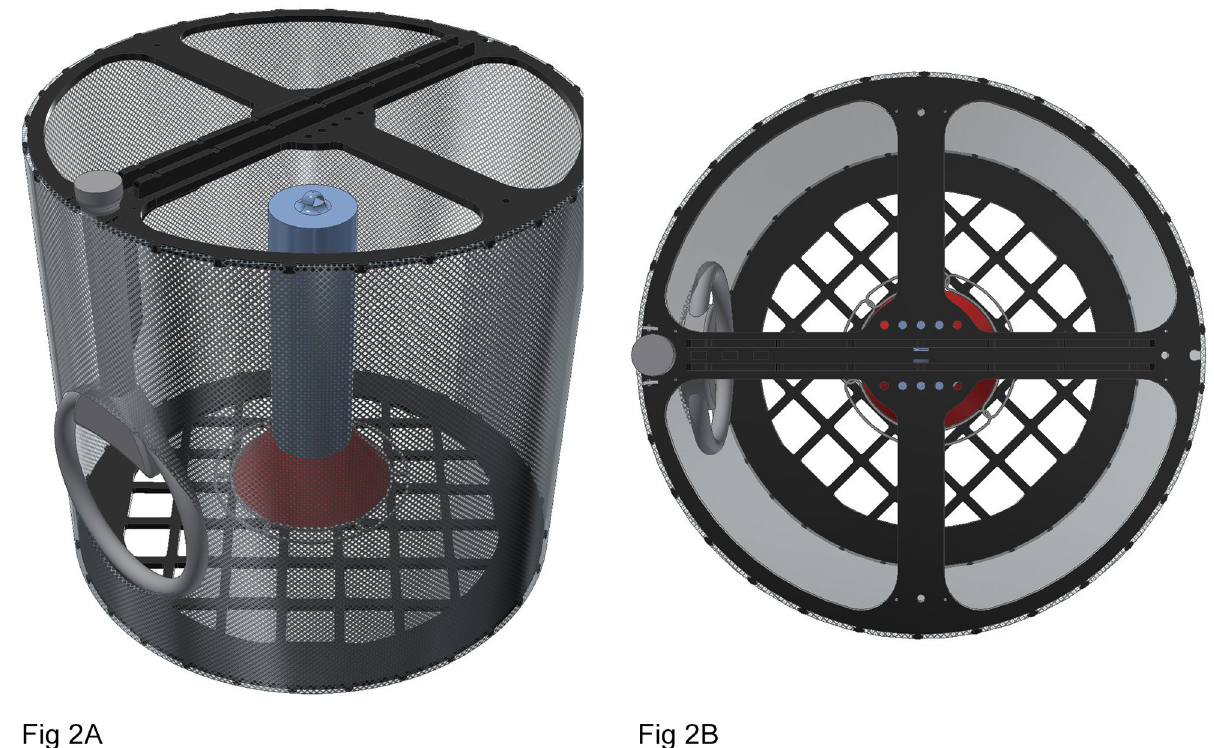
Fig 2. Computer-aided design drawings of (A) side and (B) top views of the single antenna feeding station using radiofrequency identification technology. The antenna was secured to the side of the feeder system using commercial cable ties that secured the antenna to the supporting perpendicular structure that originated from the top of the unit that extended down (A). The crossbars had drilled mounting holes, for cord string to be fed through, allowing suspension of the entire unit (B). The top portion of the unit is devoid of netting and serves as a secondary exit route for the birds.